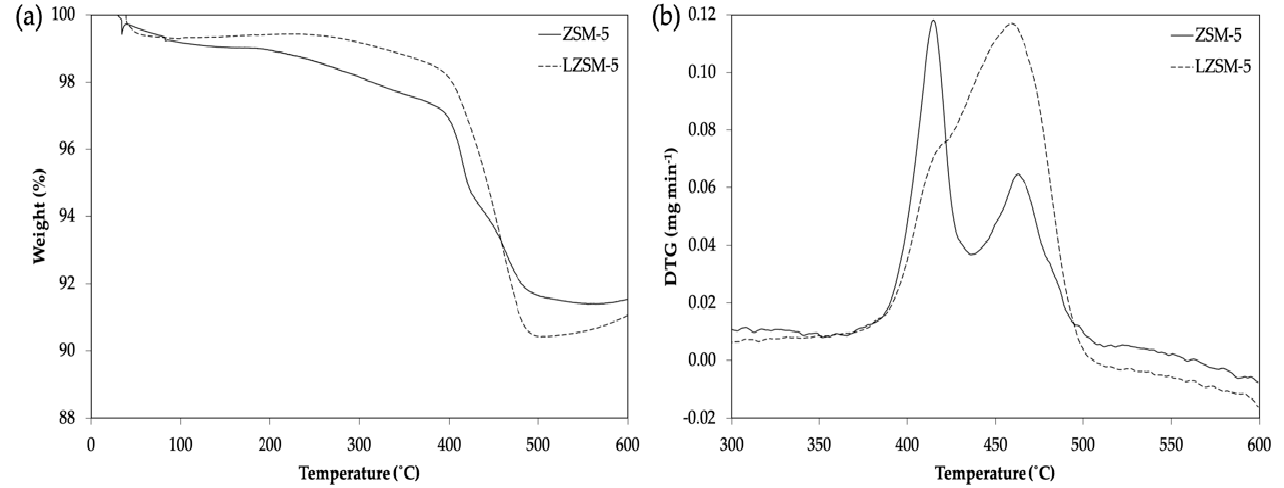
Figure 5. TGA ( a ) and DTG ( b ) profiles for ZSM-5 and LZSM-5 synthesized after 24 h.